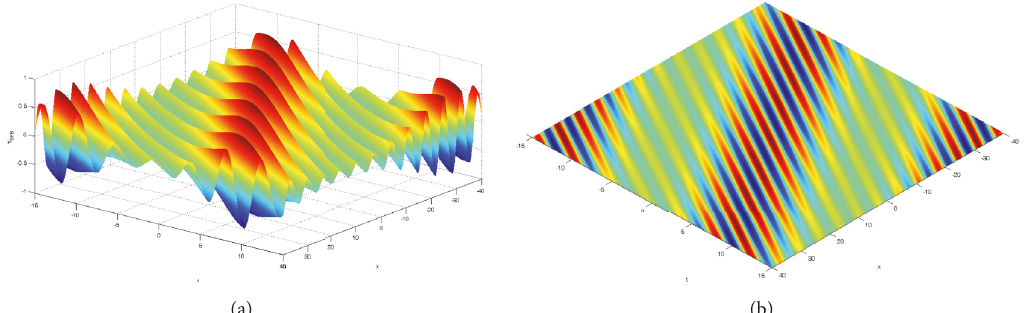
(𝑥,𝑡) for ̂ ] = 1.3 . SFB